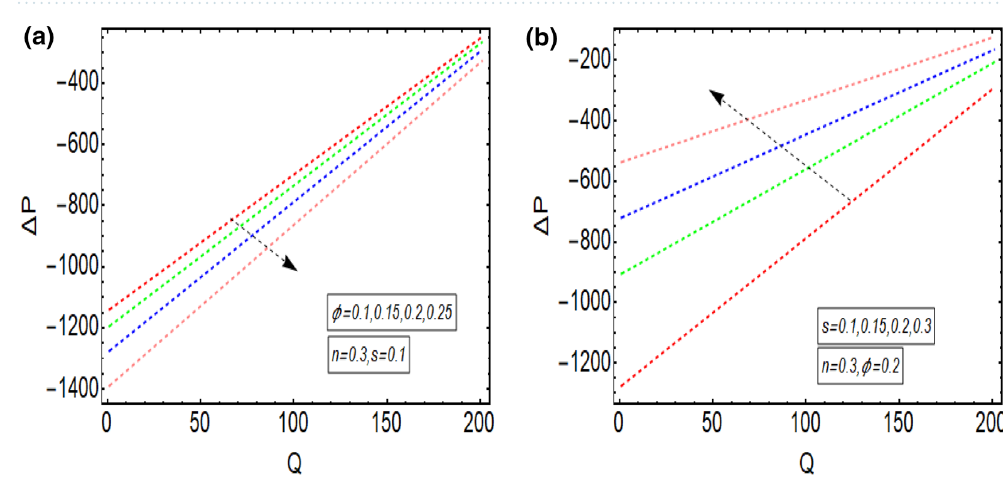
Figure 4. ( a ) (cid:31) P plot against Q for four values of φ . ( b ) (cid:31) P plot against Q for four values of s